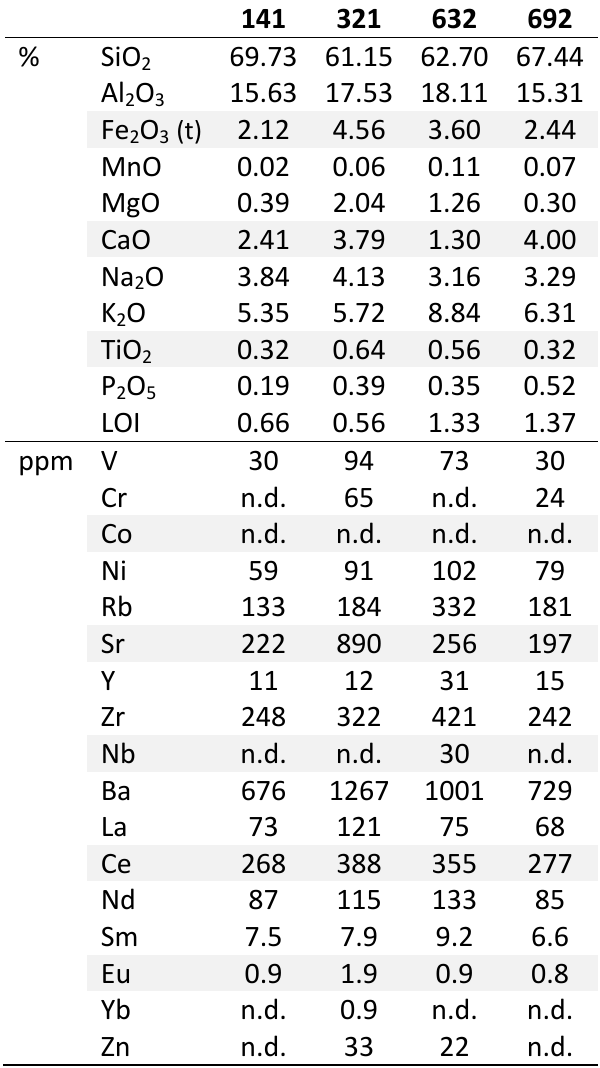
Table 2. Major and trace element composition of the Çukuriçi Höyük grinding stones (normalized; ‘n.d.’ not determined, below detection limit of